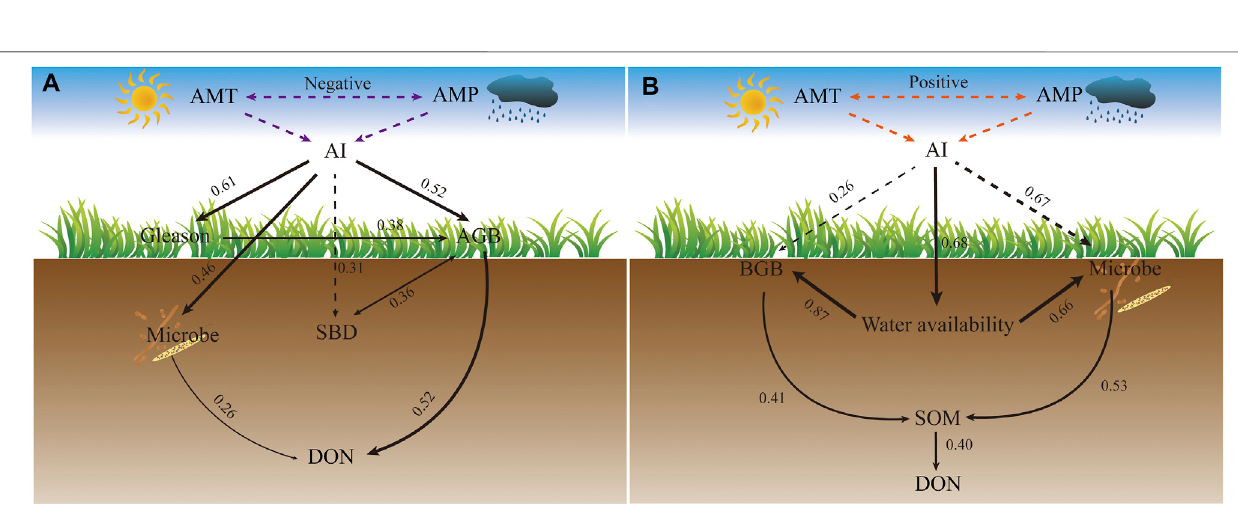
FIGURE 5 | Structure equation modeling (SEM) examining the standard total effects of environment and biological factors (soil clay (CLAY), annual mean temperature (AMT), annual mean precipitation (AMP), aboveground biomass (AGB), belowground biomass (BGB) community diversity of Shannon – Wiener (Shannon), plant diversity of Gleason (Gleason), soil water content (SWC), soil organic matter (SOM), microbe biomass carbon (MBC), and microbe biomass nitrogen (MBN)) on dissolved organic nitrogen (DON) in the LDON pattern (A) and HDON pattern (B) . Black line and its thickness represent positive relationships and their total effect value. The solid and dashed lines represent direct and indirect effects, respectively. Purple and orange dotted lines represent only the connection. Microbial factors in Figure 5A include MBC and include MBC and MBN in Figure 5B . Water availability represents SBD and SWC in Figure 5B . “ Microbe ” and “ water availability ” were the selected factors for the principal component